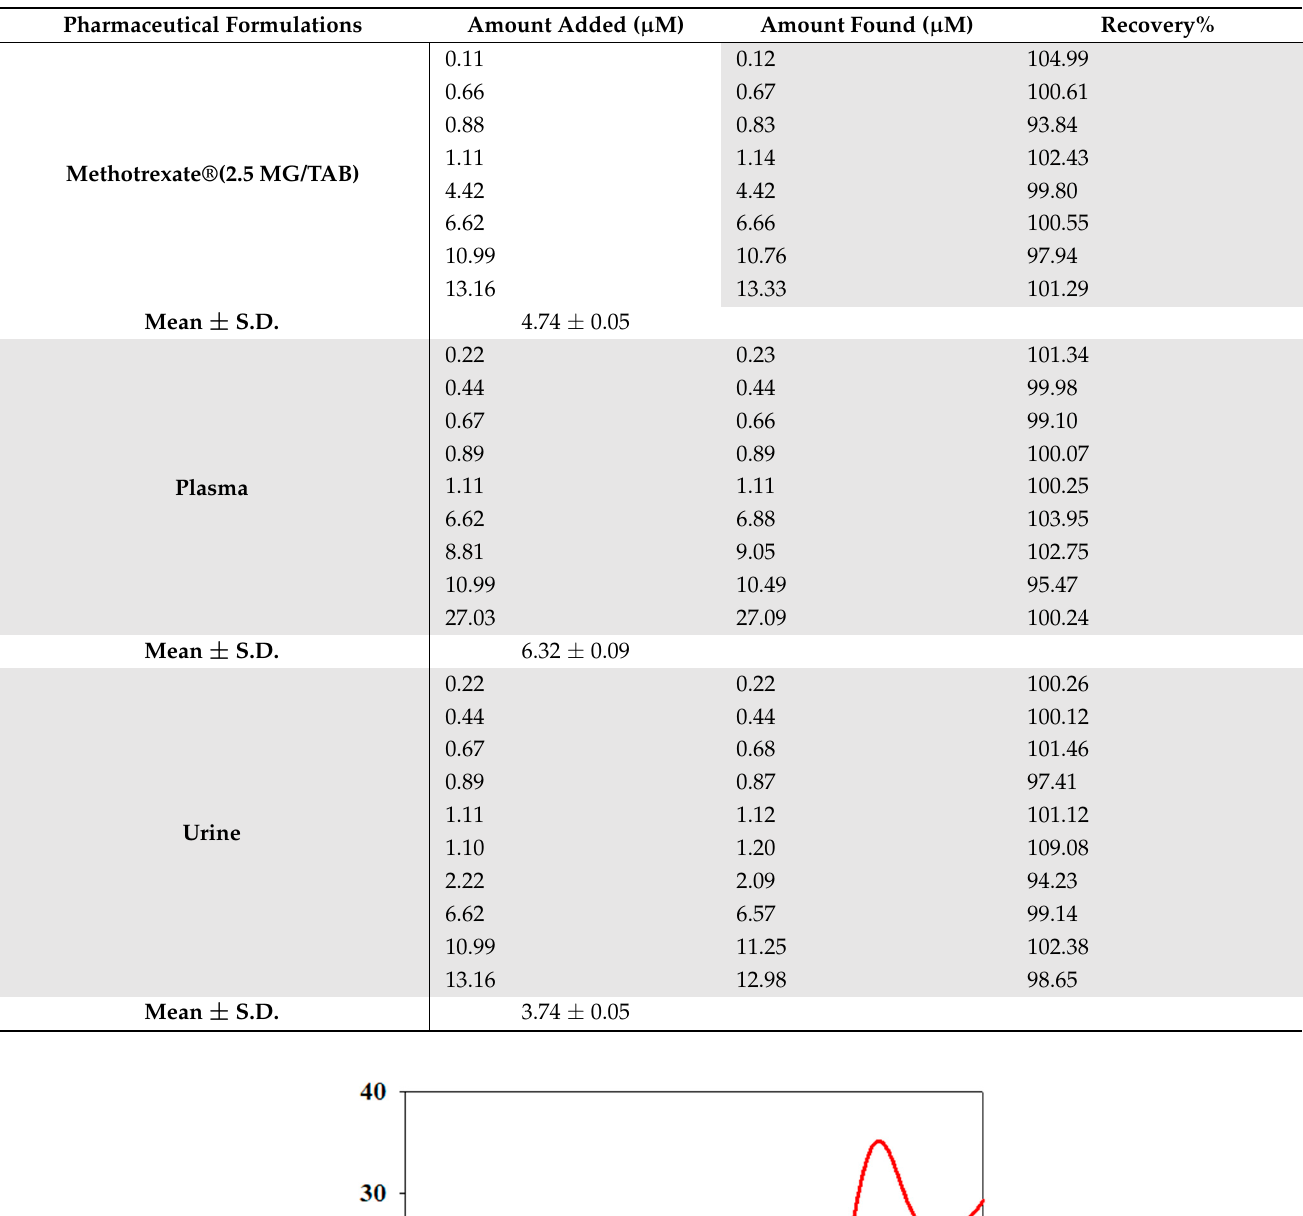
Table 3. Application of SWV for the determination of MTX in plasma, urine, and dosage form. Pharmaceutical Formulations